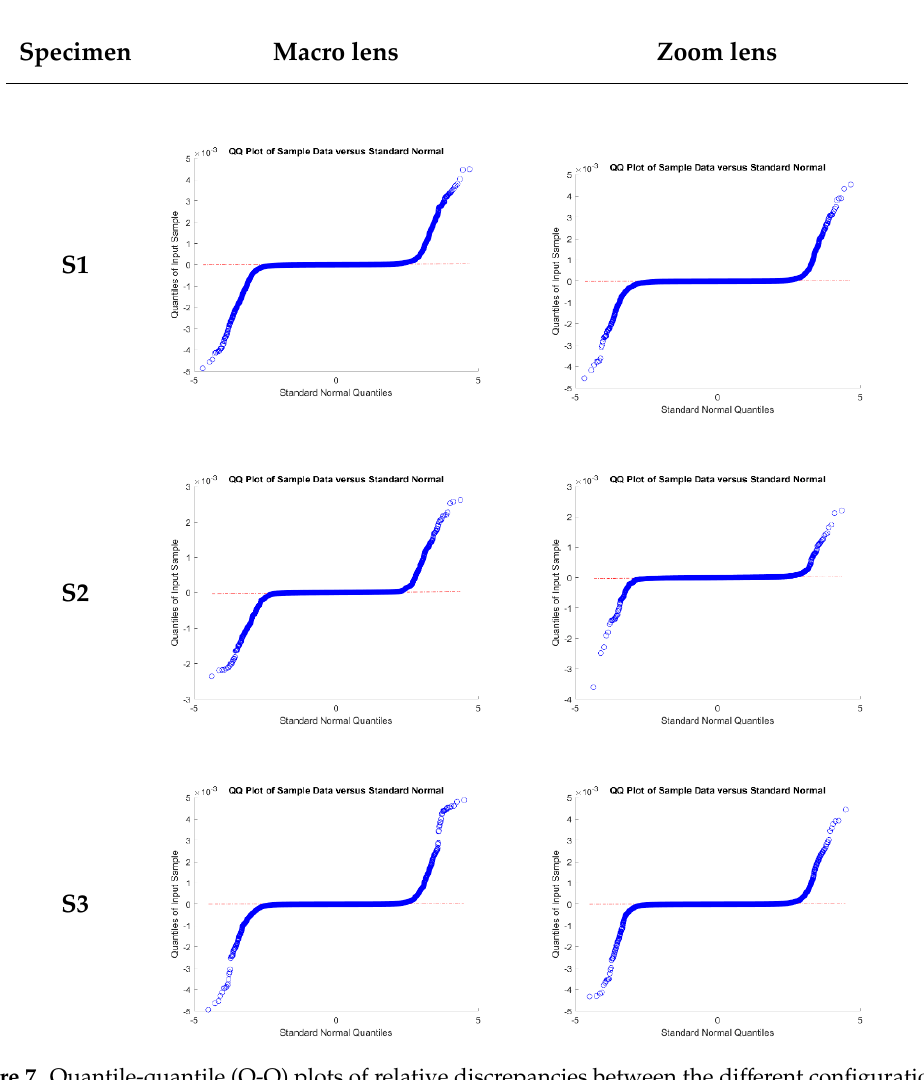
Figure 7. Quantile-quantile (Q-Q) plots of relative discrepancies between the di ff erent configurations and archaeological specimens.